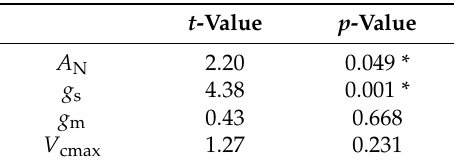
Table 1. Outputs of the Student’s t -tests performed to compare the values of net photosynthesis ( A N ), stomatal conductance ( g s ), mesophyll conductance ( g m ) and maximum velocity of carboxylation ( V cmax ) for well-watered plants before the drought period and those measured 7 days after plants were rewatered. *: Significant values at p <